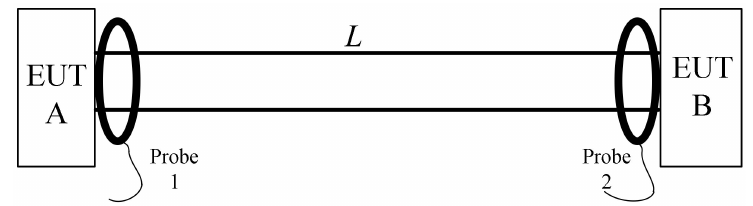
Figure 1. DBCI schematic diagram of unshielded two-wire circuit system.